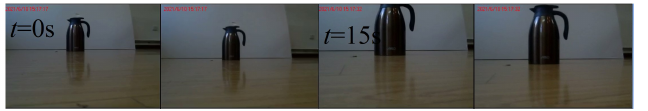
Figure 13. Video screen in the master computer from the stereo camera of the head